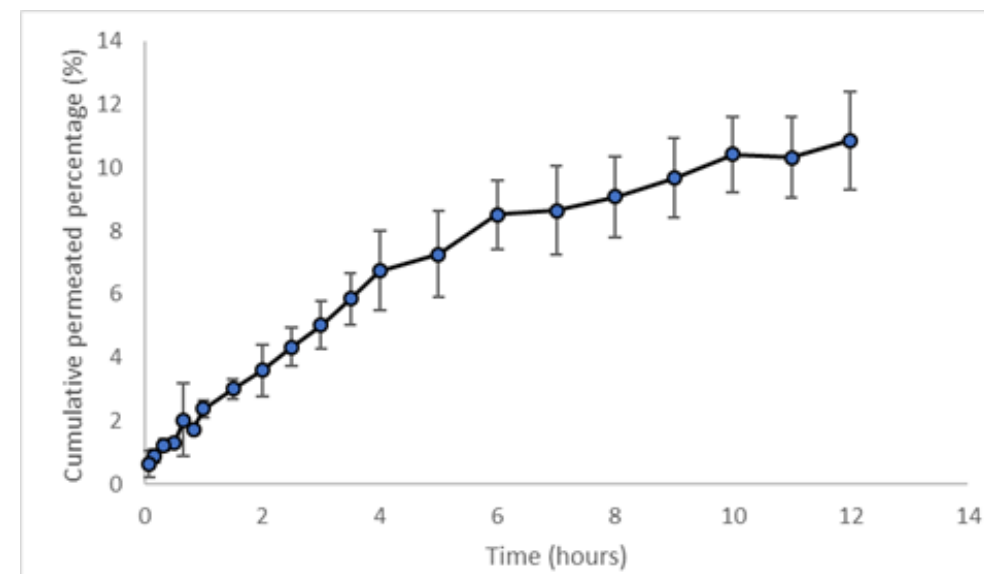
FIGURE 2 - Plot of cumulative percentage of permeated polyphenols vs time for